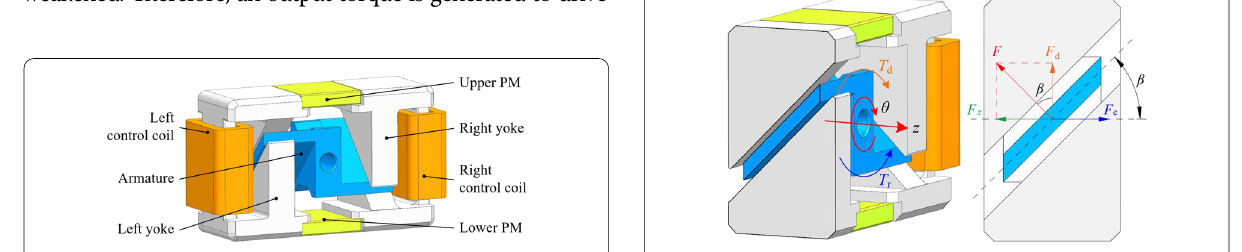
Figure 3 Schematic of force analysis of